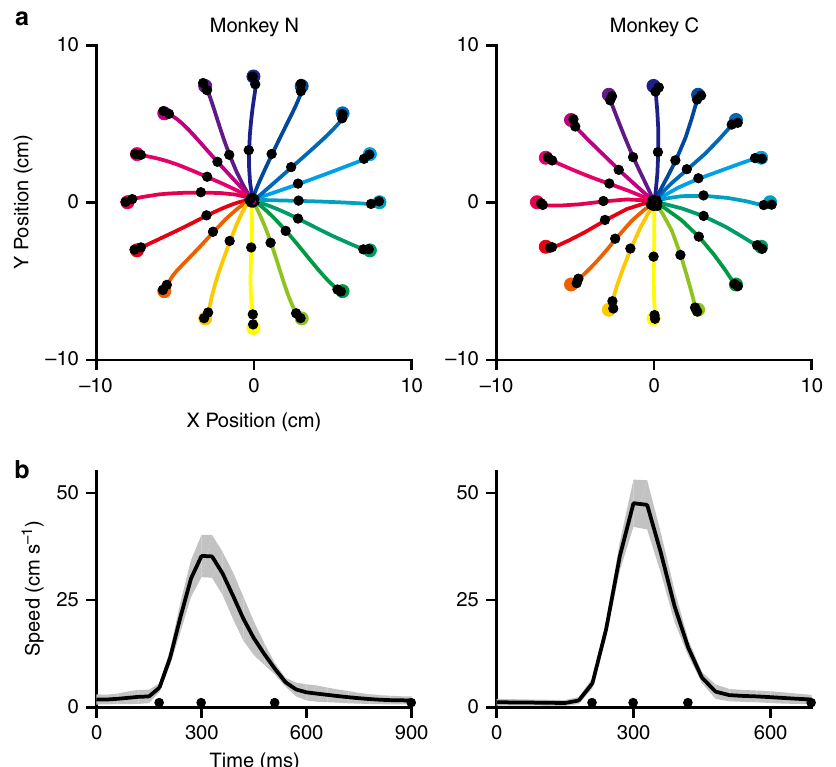
Fig. 1 Kinematic pro fi les of Monkeys N and C in the center-out reaching task. The four black dots indicate: movement onset, peak velocity, movement offset, and hold off (this marking applies to all fi gures). a Average hand trajectories, each colored trace represents a target direction (16 total). This colormap also applies to the subsequent fi gures. b Speed pro fi les pooled across all target directions with the average shown in black bold and standard deviation as the gray shaded region ( n = 69 × 16 trials for Monkey N and 47 × 16 trials for Monkey